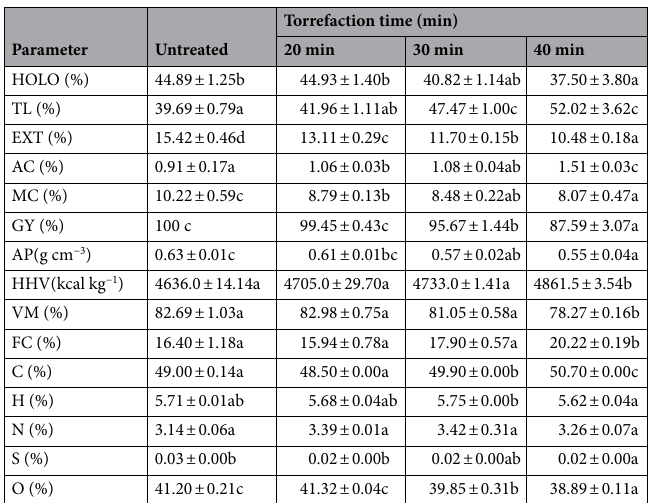
Table 1. Holocellulose (HOLO), total lignin (TL), extractives (EXT), ashes (AC), moisture (MC), gravimetric yield (GY), apparent density (AD), higher heating value (HHV), volatile materials (VM), fixed carbon (FC), carbon (C), hydrogen (H), nitrogen (N), sulfur (S) and oxygen (O) from the untreated and torrefied MDF residues. Means followed by the same letter, per line, do not differ (Tukey p >